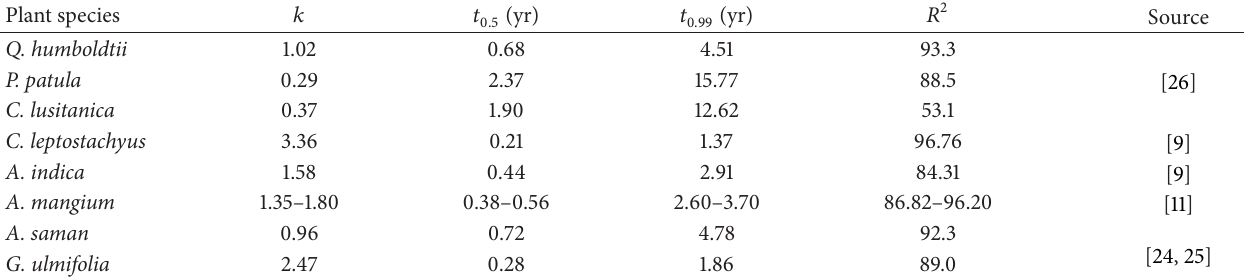
Table 3: Fitted models for residual dry matter ( 𝑋 𝑡 / 𝑋 0 ) as a function of time for forest species from restoration projects in Colombia. Plant